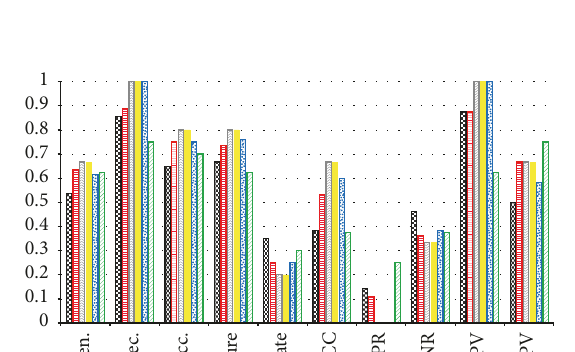
Figure 8: TsEn performance.